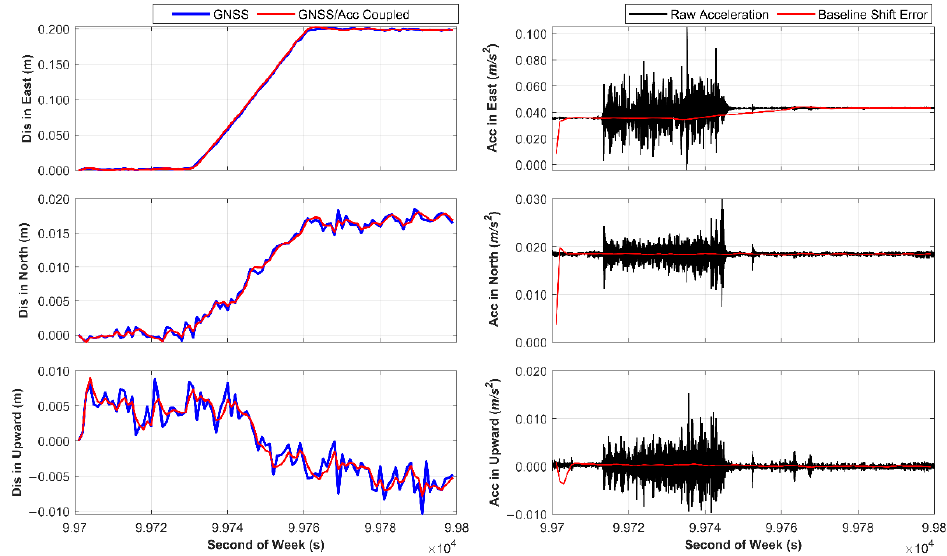
Figure 6. Coupled displacement ( left ) and BSE results ( right ) of the simulated landslide sliding period in Scene 1.